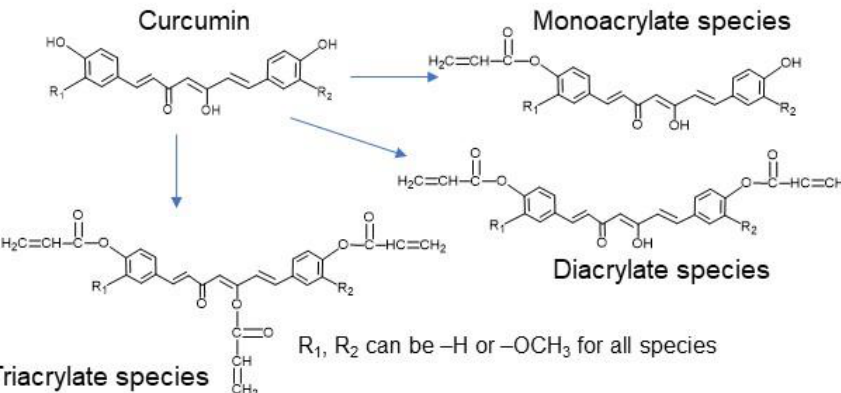
Figure 12. Chemical structure of curcumin and curcumin acrylates formed after the reaction of curcumin with acryloyl chloride. curcumin with acryloyl